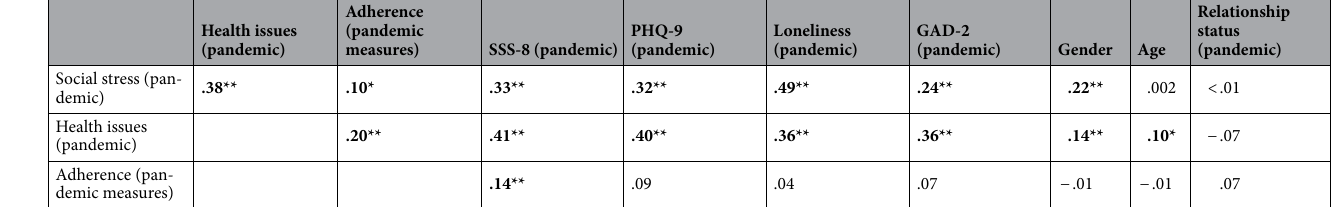
Table 3. Spearman Rank correlations between pandemic-related variables and outcome measures, gender, age, and relationship status during the pandemic. Bold values are statistically significant. SSS-8 Somatic